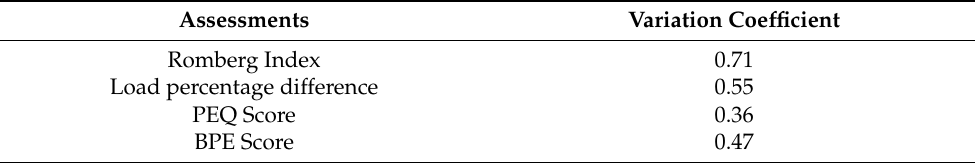
Table 2. Coefficient of variation.